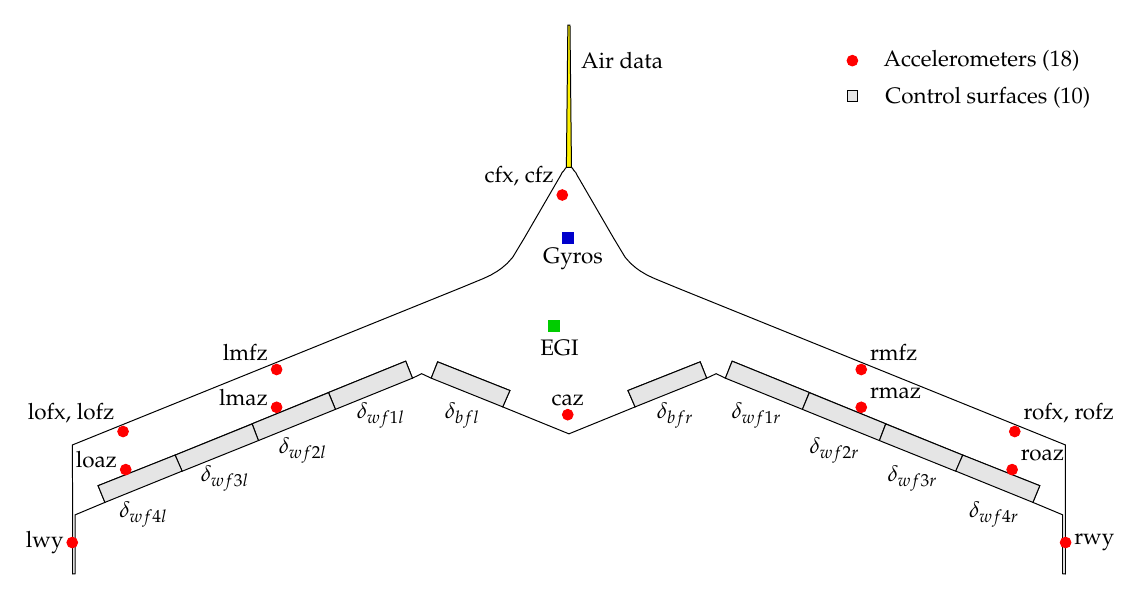
Figure 3. X-56A planform with selected sensor and control surface